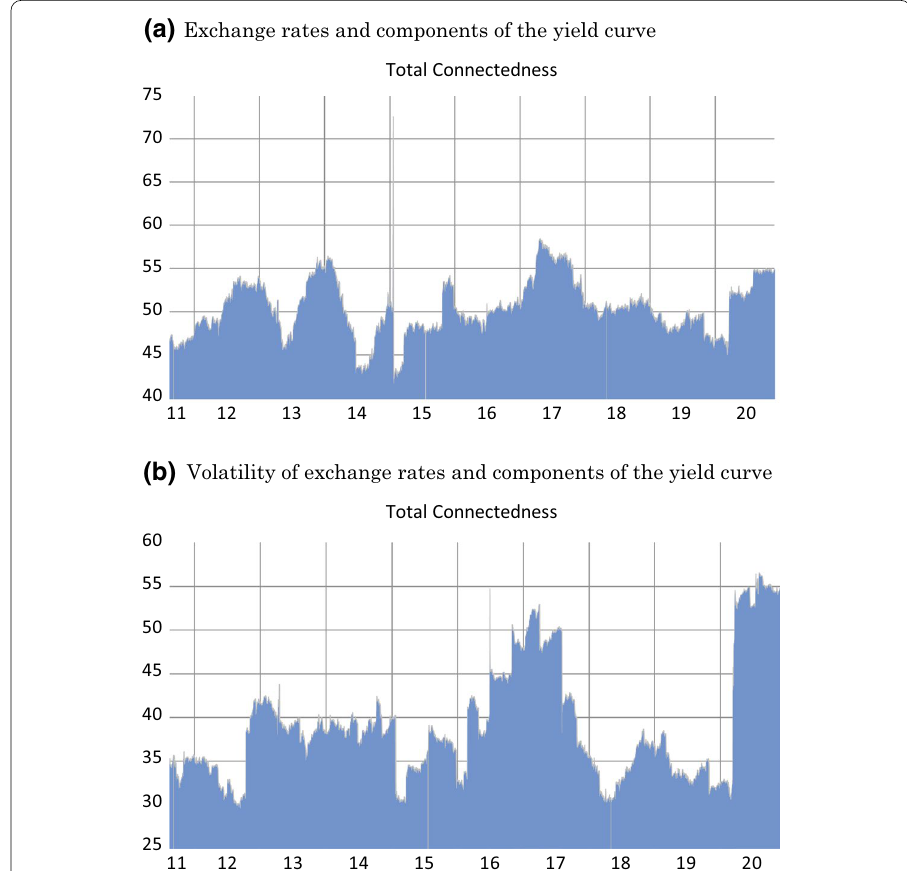
Fig. 2 Total Dynamic Connectedness Measures of the System. a Exchange rates and components of the yield curve. b Volatility of exchange rates and components of the yield curve. Notes: The figures present the total directional connectedness of the US yield curve components (level, slope, and curvature), the Bitcoin, and safe haven currencies (Euro, JPY, CAD, CHF, GBP) in a dynamic fashion. The upper figure is illustrates the dynamic connectedness of the yield curve components and the exchange rate of Bitcoin and the safe haven currencies, while the bottom depicts the connectedness of the yield curve components and the volatility of Bitcoin and the safe haven